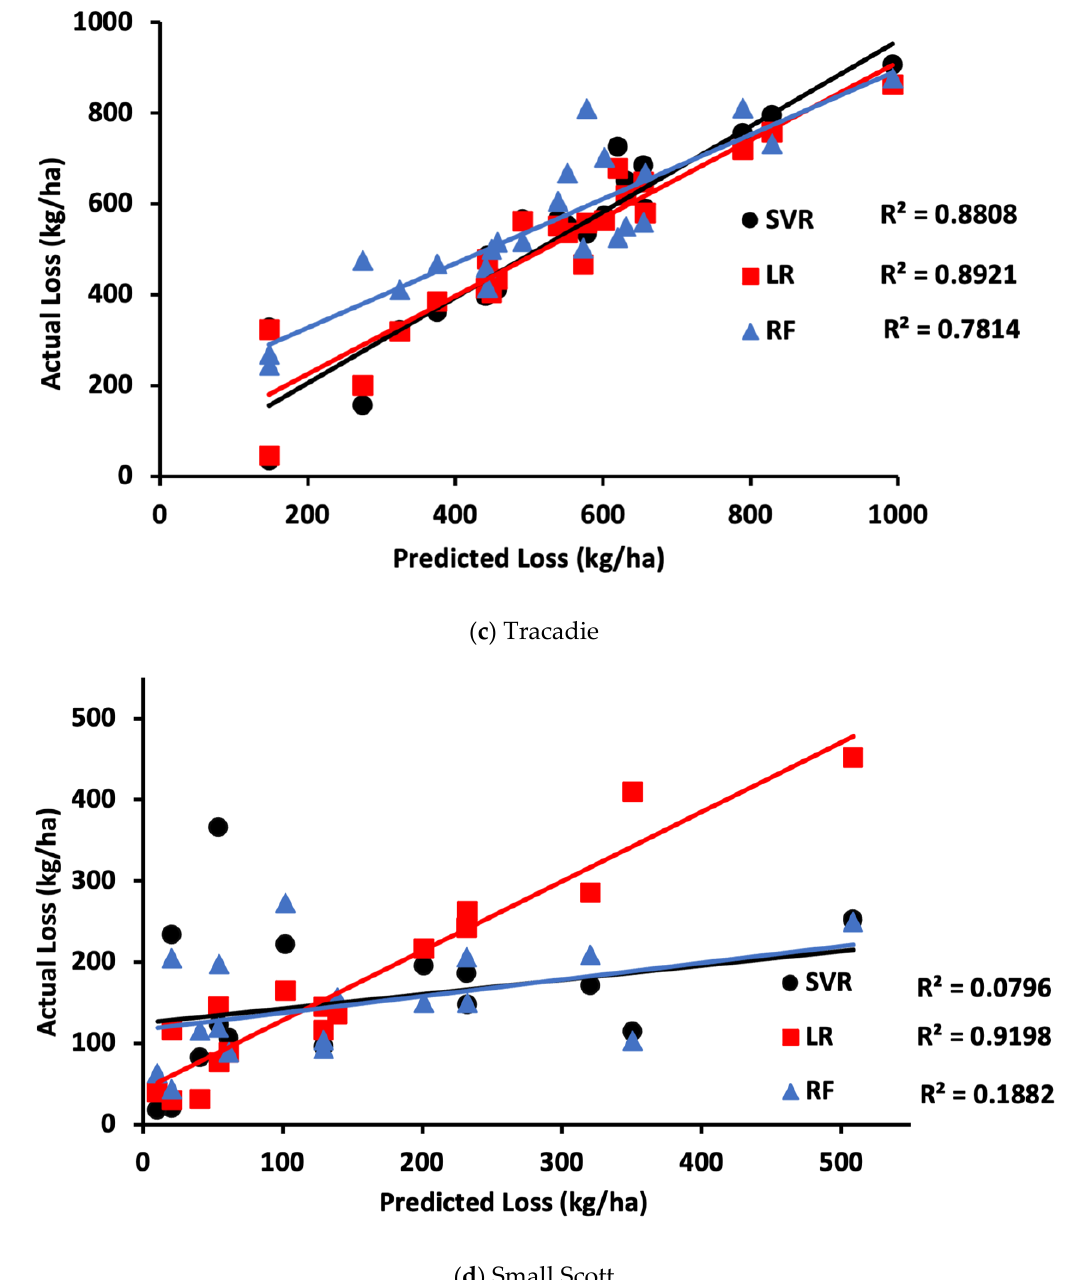
Figure 3. Comparison of actual and estimated ground loss within the selected fields.